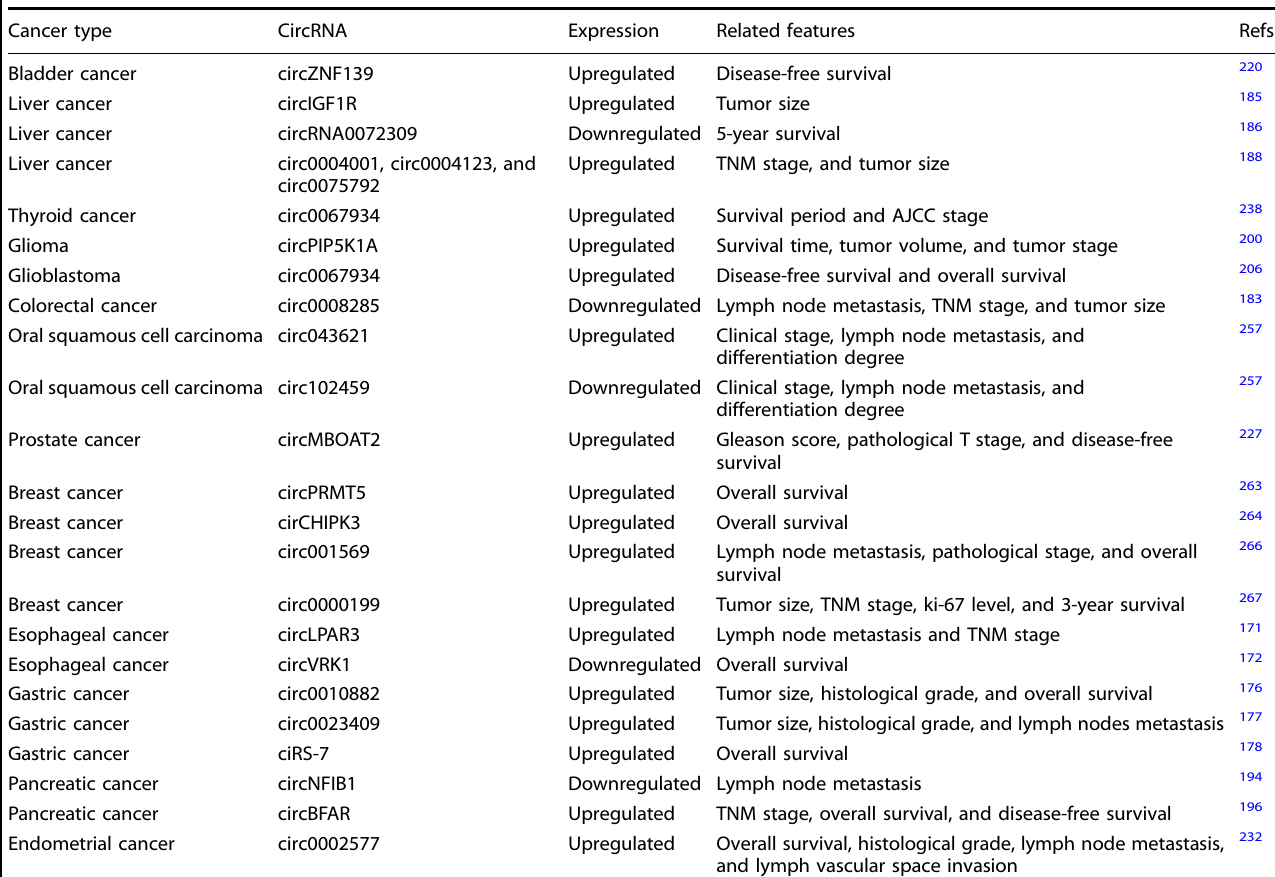
Table 2. Relationship between circRNA/PI3K/AKT axis and clinical features in cancer Cancer